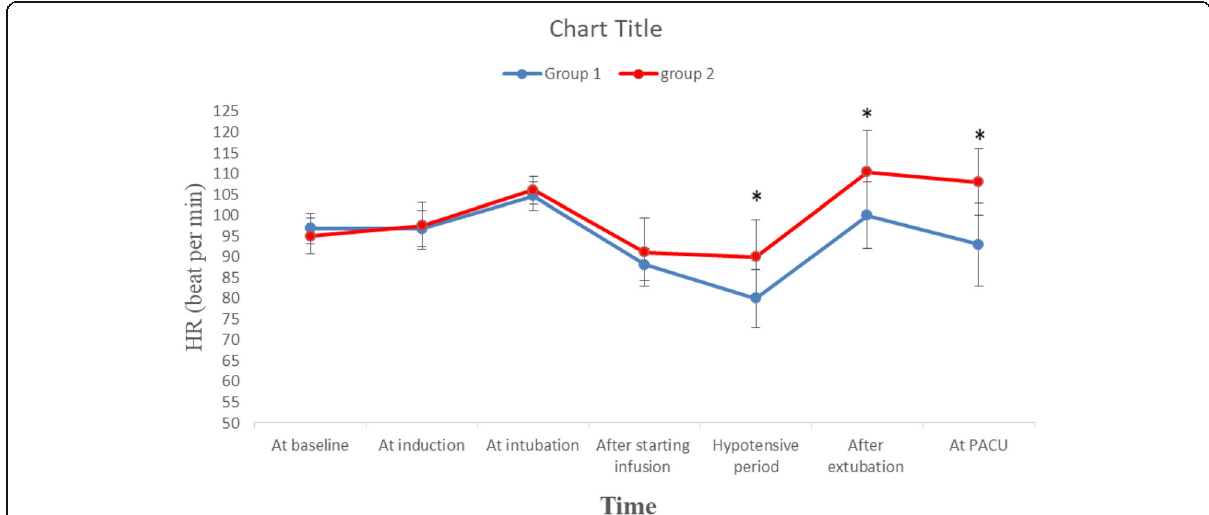
Fig. 2 HR at various times of measurements of the studied groups. Asterisk indicates significant difference between the studied groups.